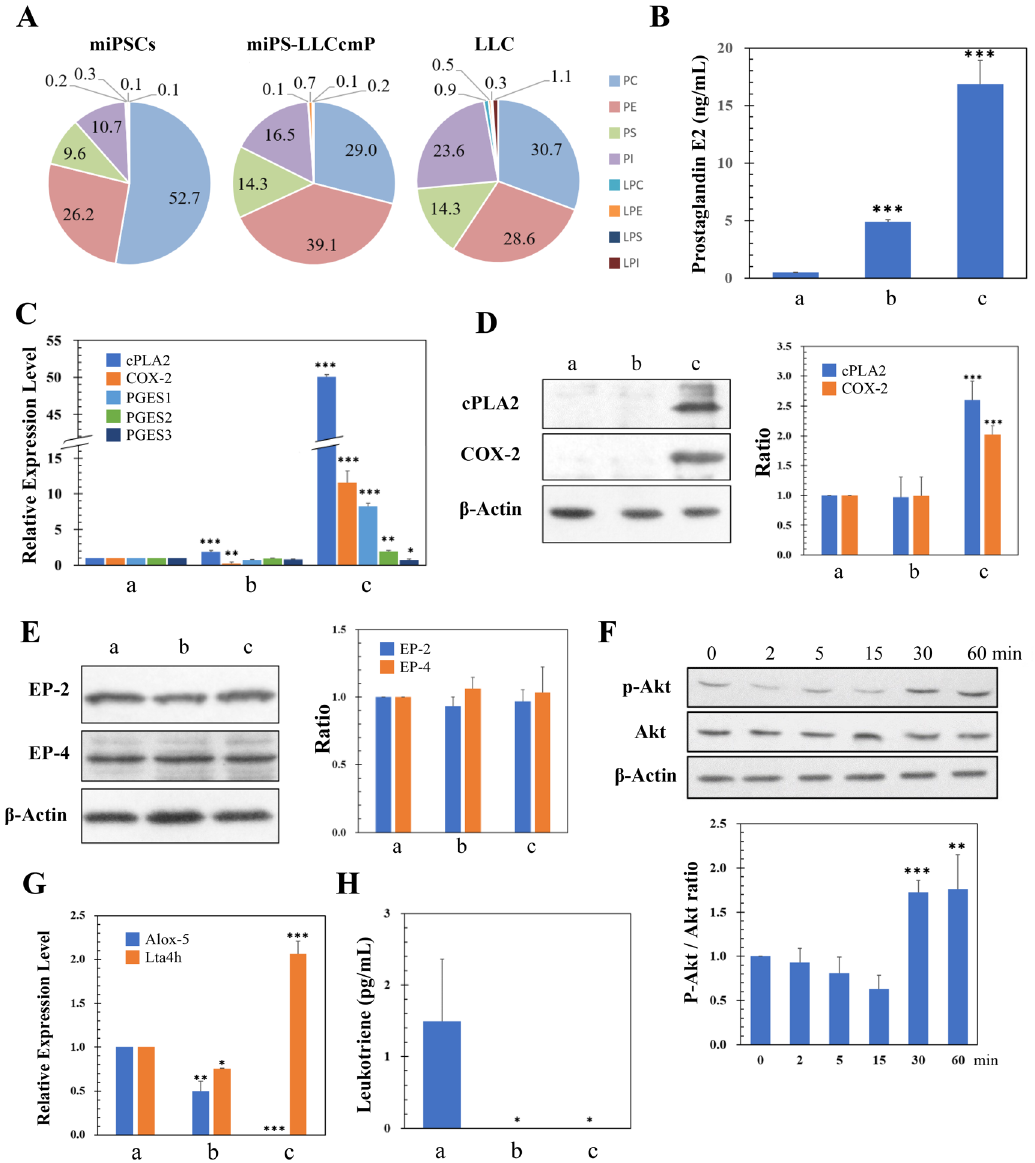
Figure 1. Comparison of the characters between miPSCs, miPS-LLCcmP cells and LLC cells. ( A ) Comparison of the glycerophospholipid composition ratio. ( B ) Comparison of PGE2 production by